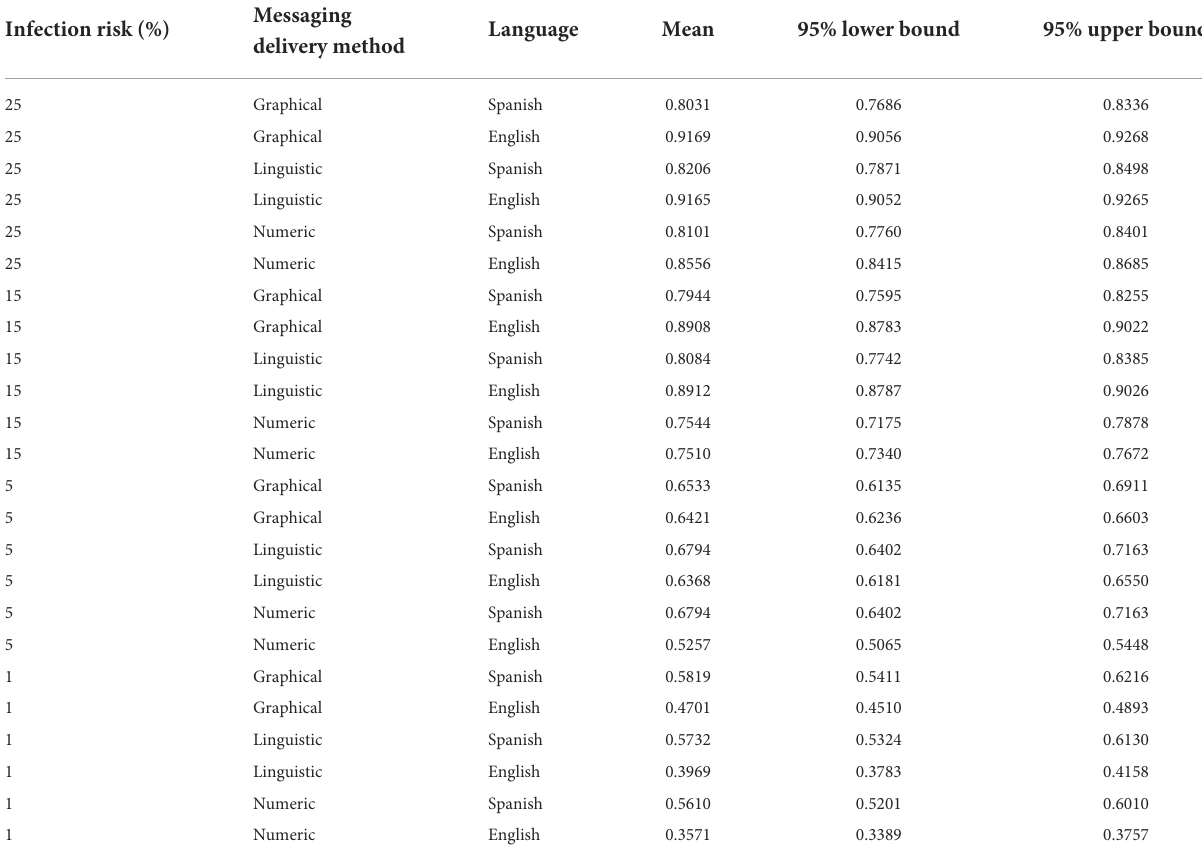
TABLE 2 Observed frequency of shower practice by treatment and covariate